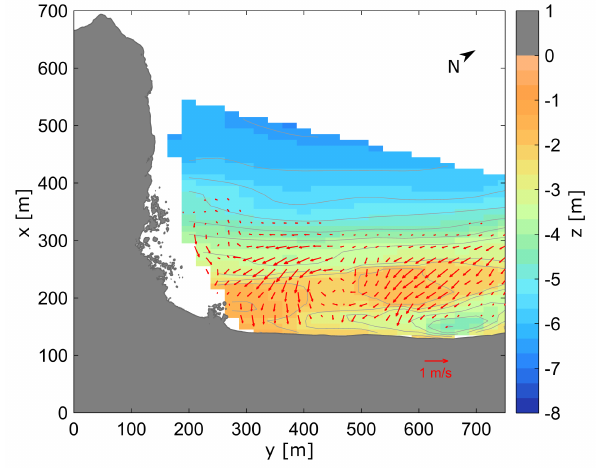
Figure 11. Optical flow image-derived surf-zone circulation (red arrows) superimposed on cBathy - estimated bathymetry for the same time period when the rip channel was present